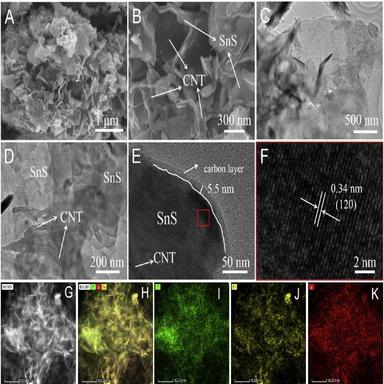
(A, B) SEM, (C, D, E) TEM, (F) HRTEM, (G) HAADF-STEM image and (HeK) corresponding elements mapping of SnS/CNT@C composite.